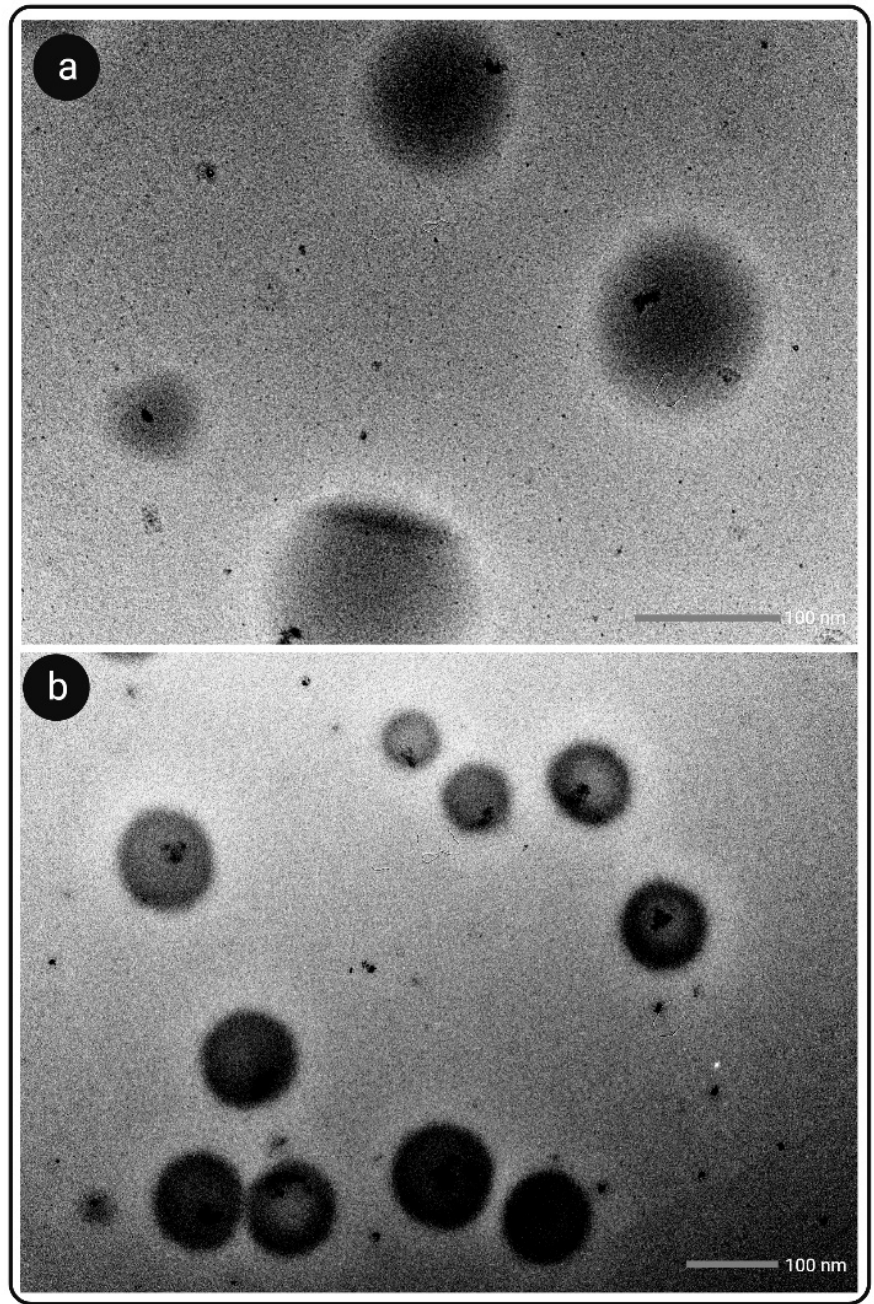
Figure 4. TEM images of ( a ) L-SNEDDS and ( b ) S-SNEDDS .